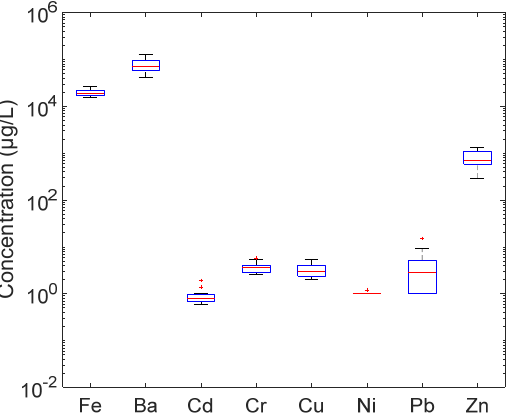
Figure 4. Produced water composition_Total and dissolved hydrocarbon concentrations.